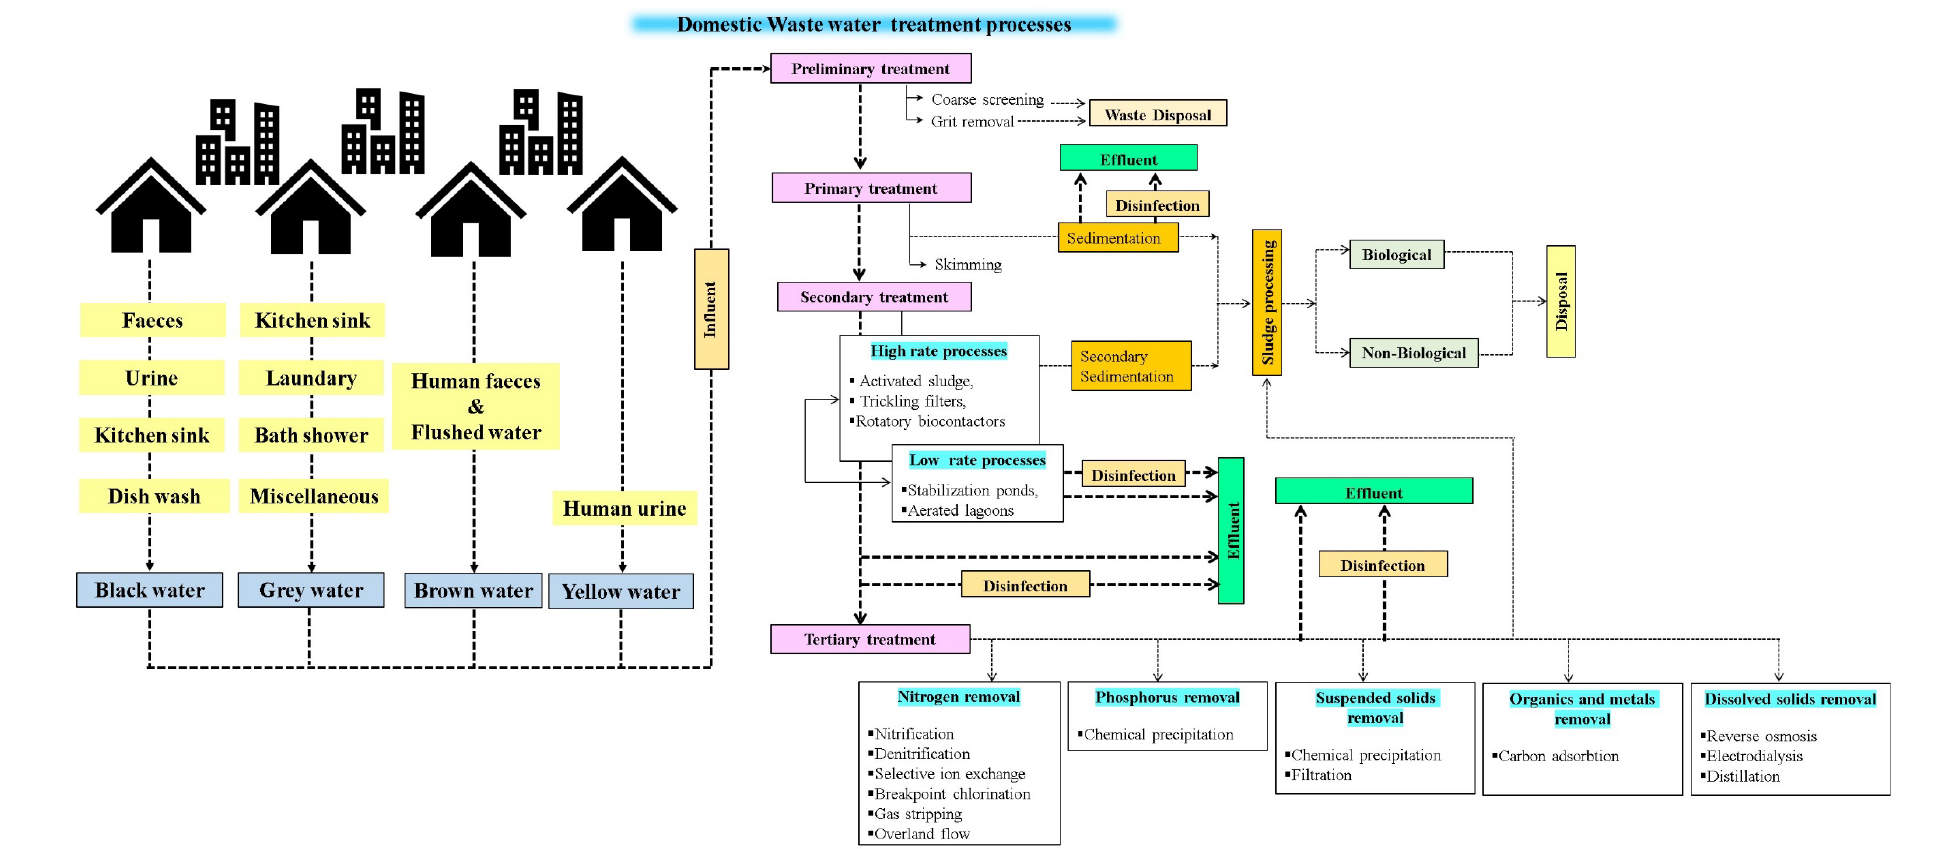
Figure 2. Schematic representation of a general domestic wastewater treatment (WWT) regime.